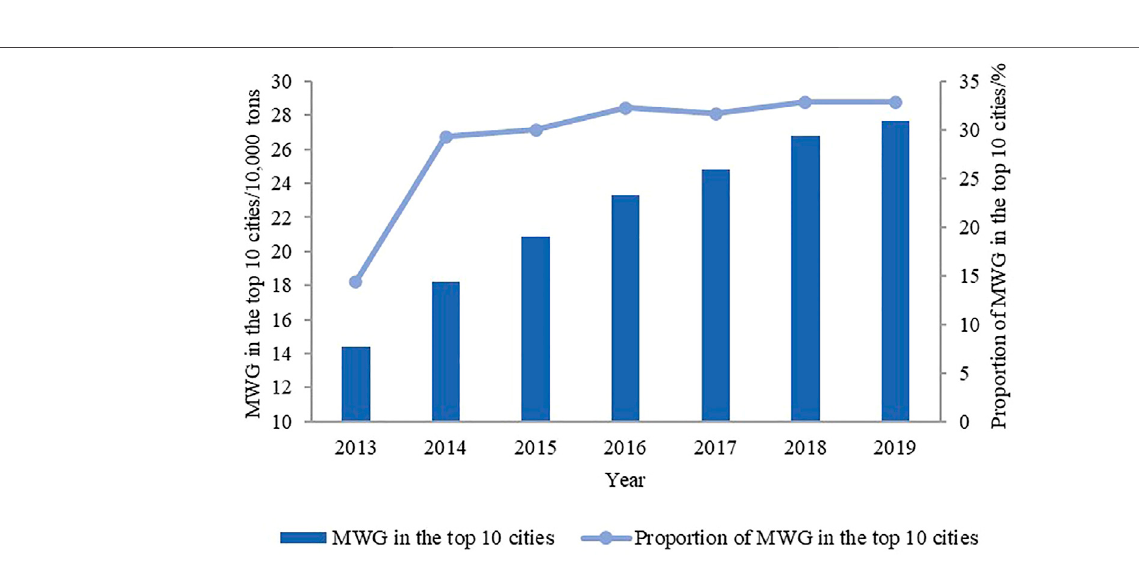
FIGURE 1 | Number of cities that published medical waste statistics each year and annual MWG.